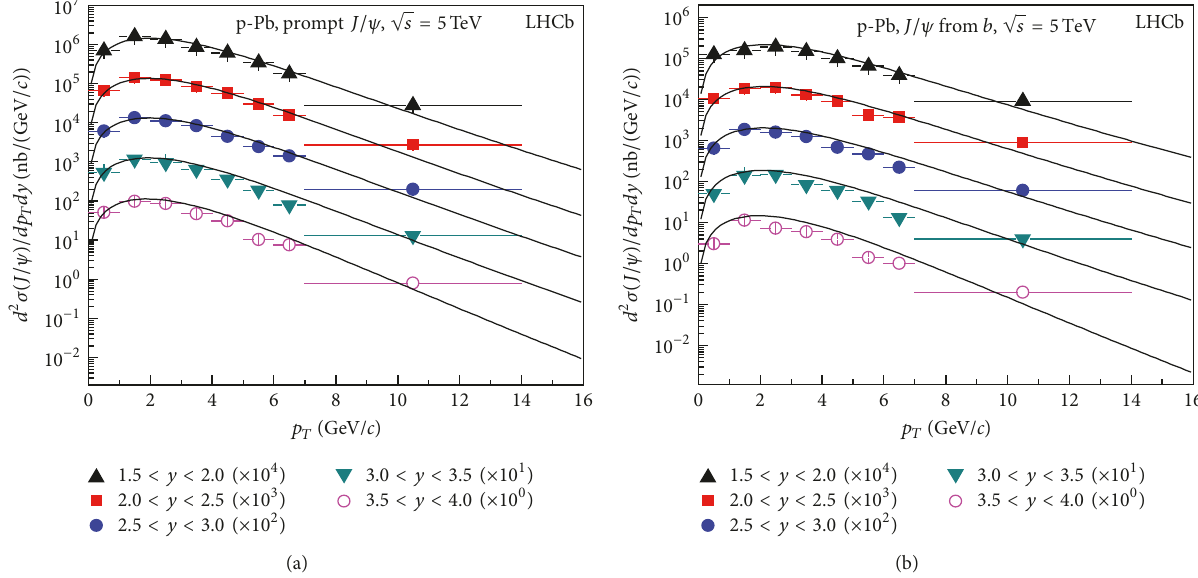
Figure 5: Same as Figure 2, but for p-Pb collisions at √𝑠 NN = 5 TeV. The experimental data are taken from the LHCb Collaboration [27].